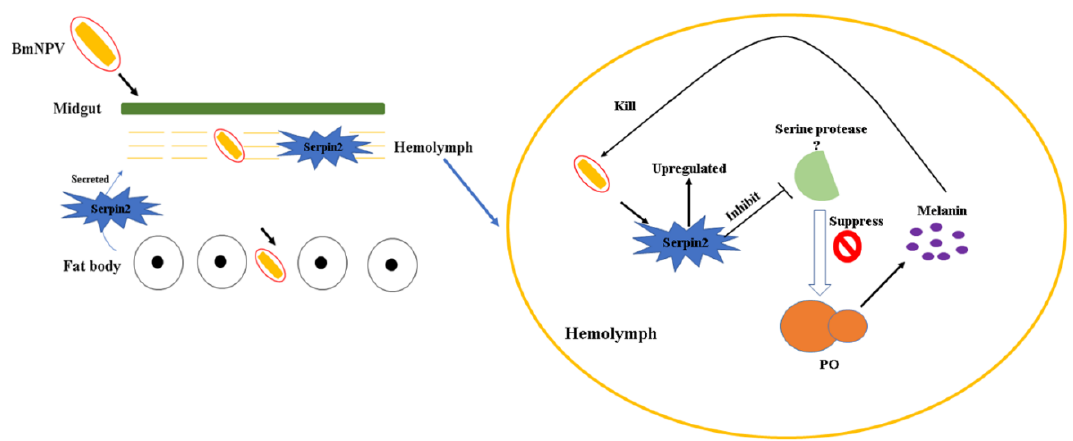
Figure 11. A proposed diagram of role of Bmserpin2 in the regulation of the PO cascade after BmNPV infection.